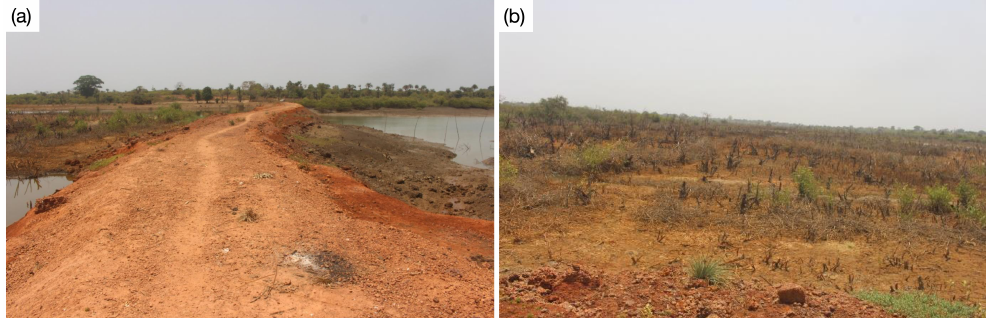
Figure 14. Example field photos taken during the field visits to the area shown in Figure 13. ( a ) The dam was built to hold back the tidal waters allowing for rice cultivation. ( b ) An area behind the dam where mangroves have started to be removed to be converted into rice paddies. Credit: